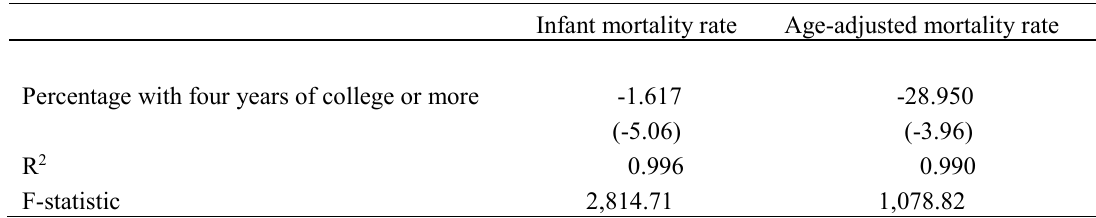
Table 2: Infant and age-adjusted mortality regressions a